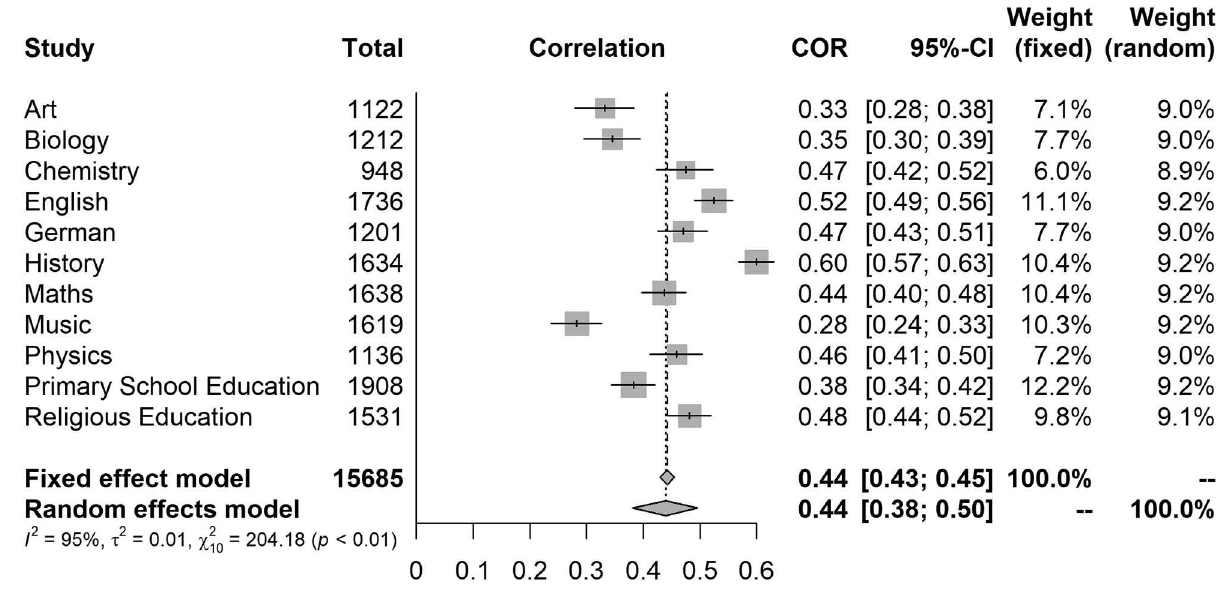
Frontiers in Education |